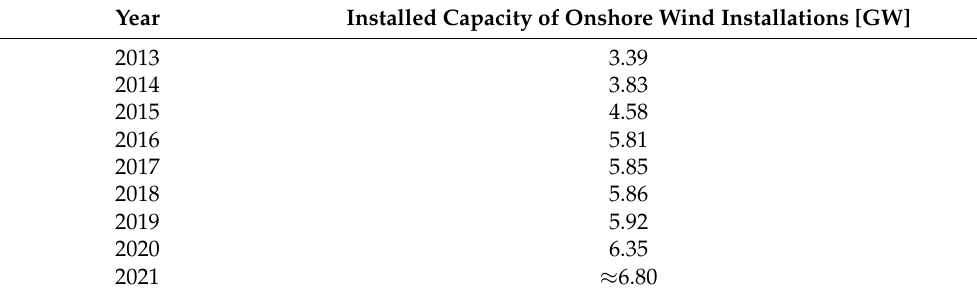
Table 2. Dynamics of the WE market in Poland